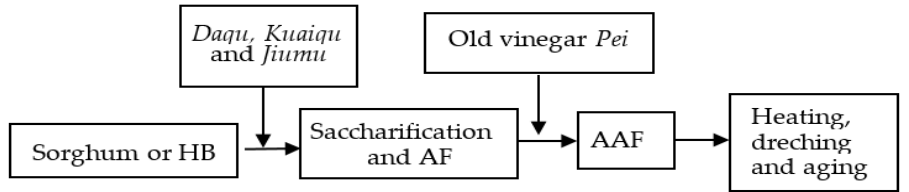
Figure 1. The process flow chart for Shangxi aged vinegar.